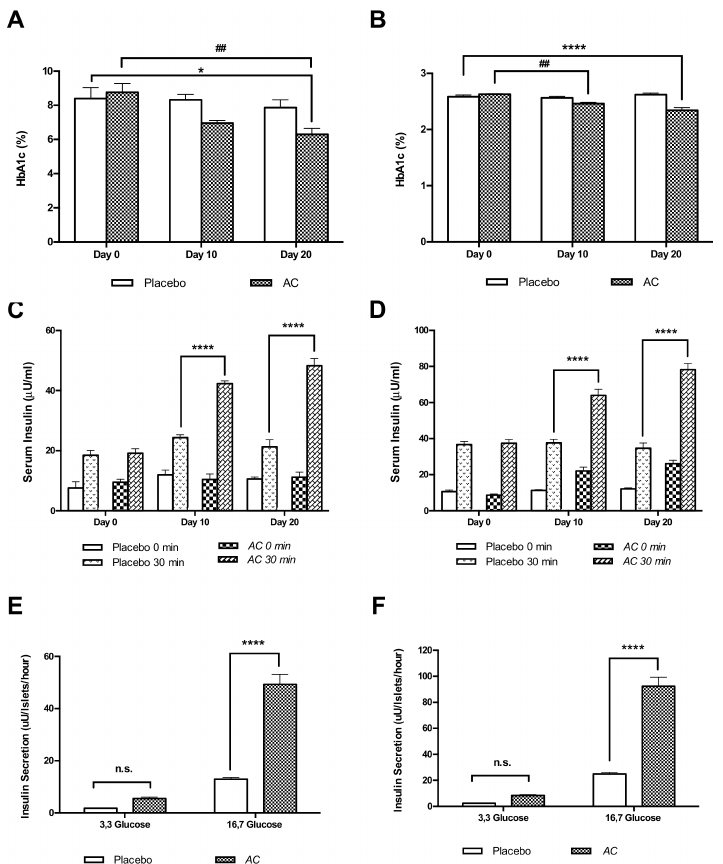
Figure 6. AC oral long-term treatment reduces the plasma HbA1c, increases serum insulin, and improved insulin secretion in pancreatic islets of treated animals. The plasma HbA1c were measured during each OGTT in GK rats ( A ) and in W rats ( B ); Serun Insulin were measured during each OGTT in GK rats ( C ) and in W rats ( D ) Data are presented as means ± SEM ( n = 6). Pancreatic islets were isolated at the end point of treatment (day 21) from GK rats ( E ) and W rats ( F ) were cultured at low (3.3 mM) and high (16.7 mM) glucose. Data are presented as means ± SEM ( n = 4). Insulin concentration was measured by RIA. * p < 0.05, **** p < 0.0001 when compared to placebo group; ## p < 0.01, when compared to values from the same